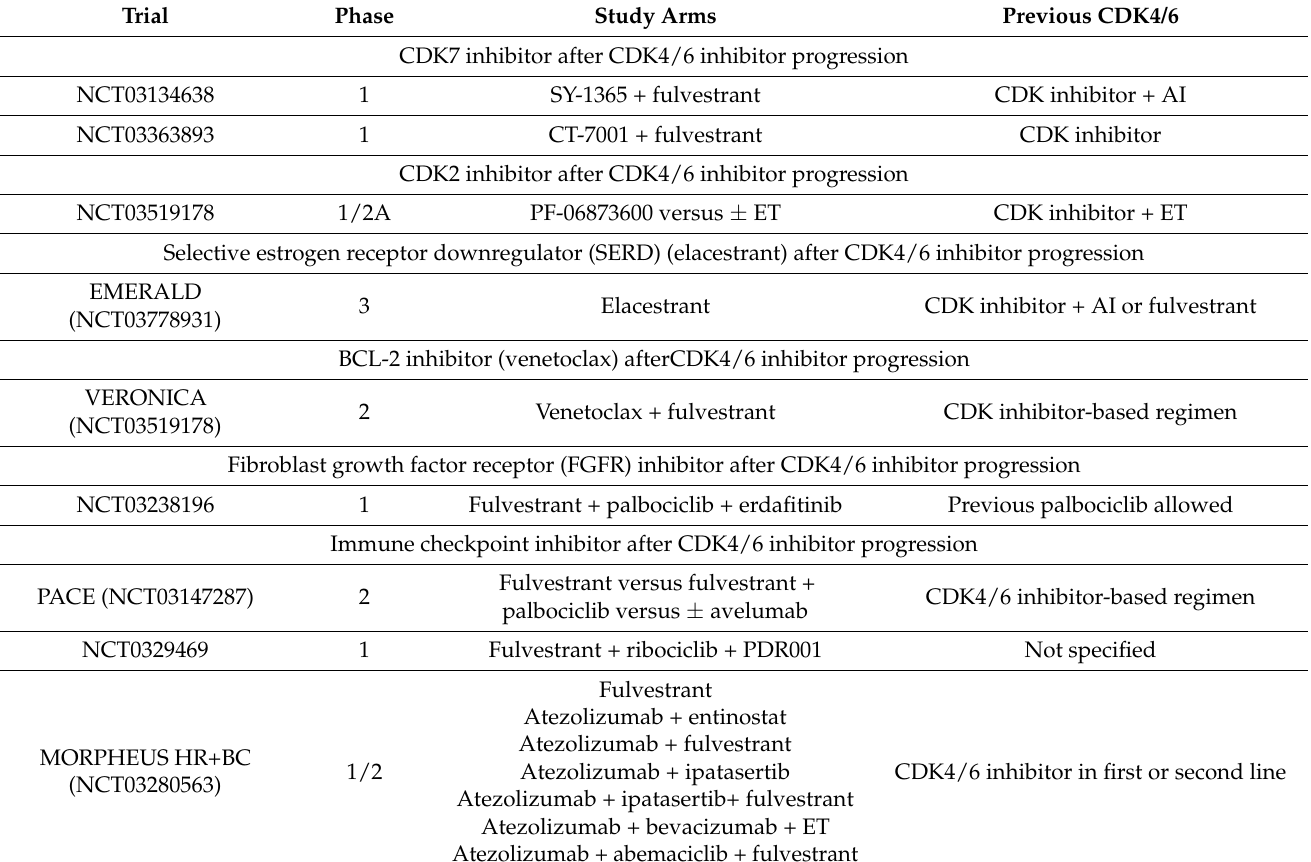
Table 4. New agents after CDK4/6 inhibitor